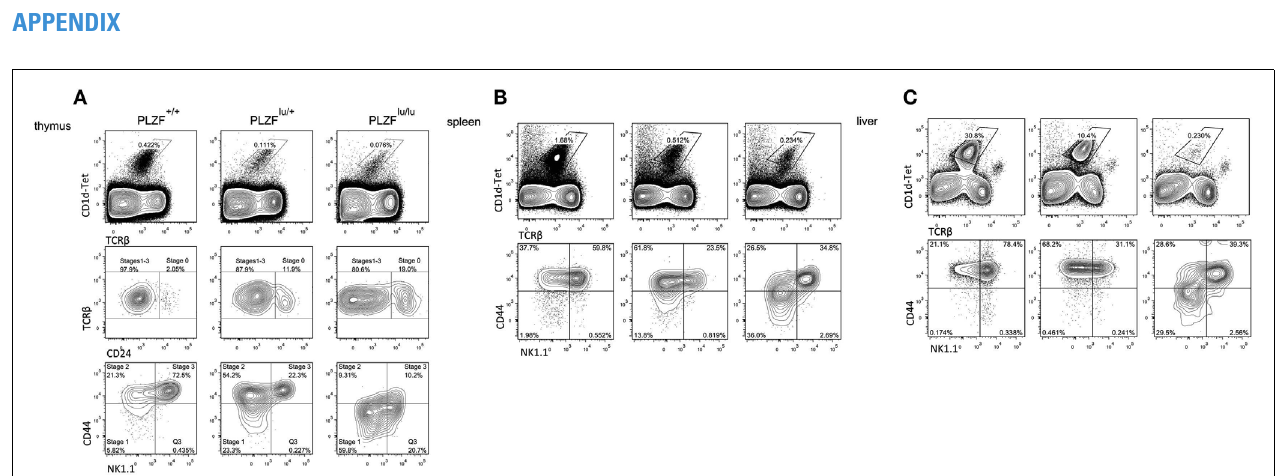
indicated genotype were isolated and stained with PBS-57-loaded CD1d tetramers and antibodies againstTCRß, CD24, CD44 and NK1.1.